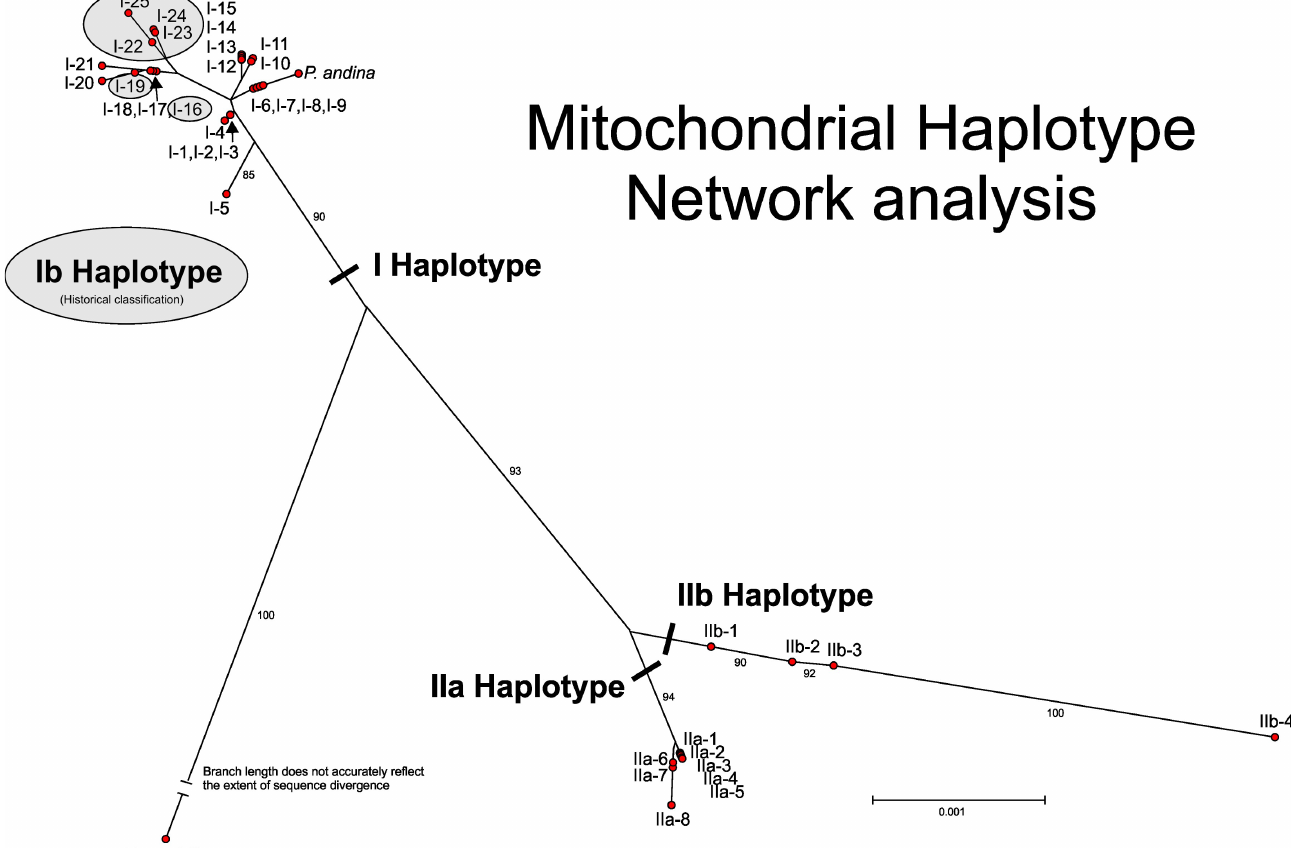
Fig 2. Mitochondrial haplotype network for Phytophthora infestans calculated by SplitsTree 4.10 [50] using uncorrected P with gaps included in the analysis and a neighbor joining network. Bootstrap support for main clades (1000 replicates) indicated by the smaller numbers on specific branches. Haplotypes in Haplogroup I not shaded represent Ia